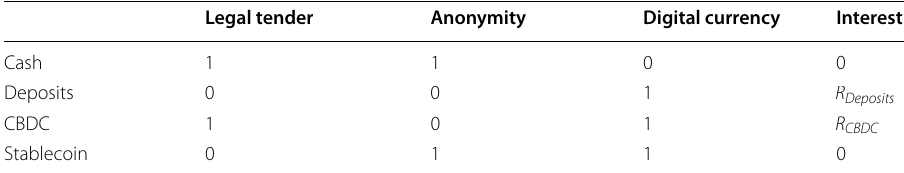
Table 1 Utility-contributing features of the payment assets